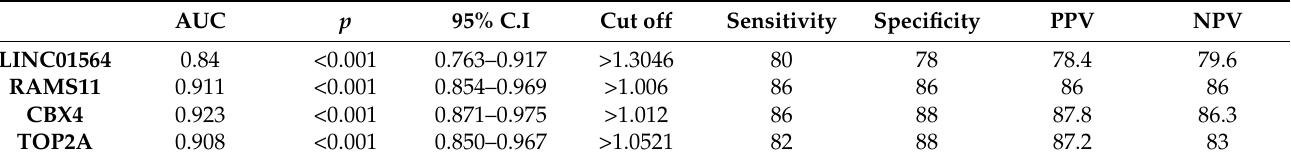
Table 4. Diagnostic performance of different parameters to discriminate HCC group form HCV group.